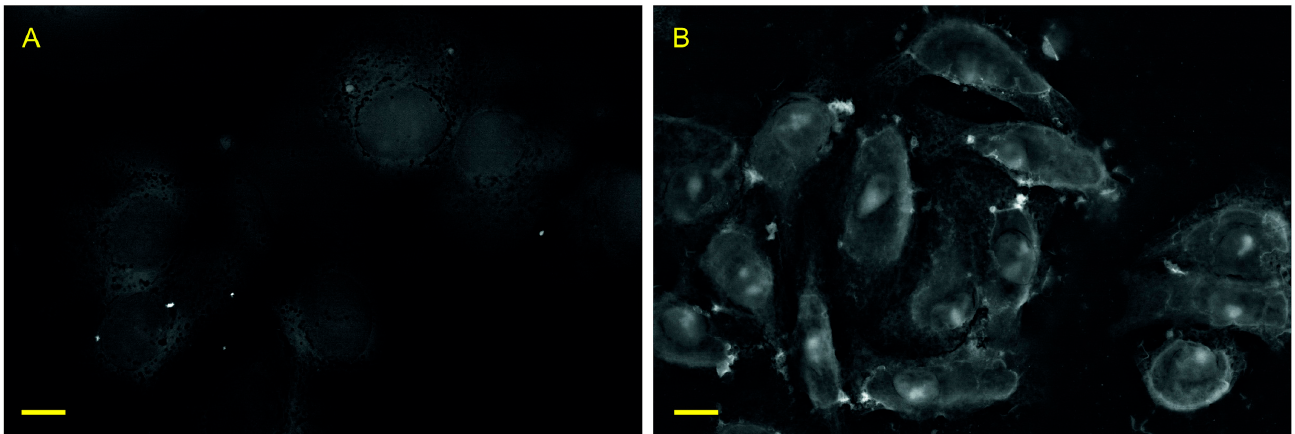
Figure 2. Scanning electron microscopy (SEM) image (in back-scattered electrons detection (BSD) mode) of control cells without treatment ( A ) and BR20min-cells after 20 min of lathanoid treatment ( B ), followed by water washing and 10 min at vacuum (70 Pa). Scale bar: 10 µm.